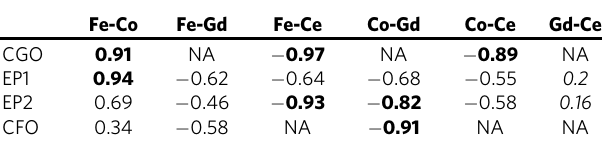
Table 2 Linear correlation trends of four metal elements in different phases, estimated using the Pearson correlation coef fi